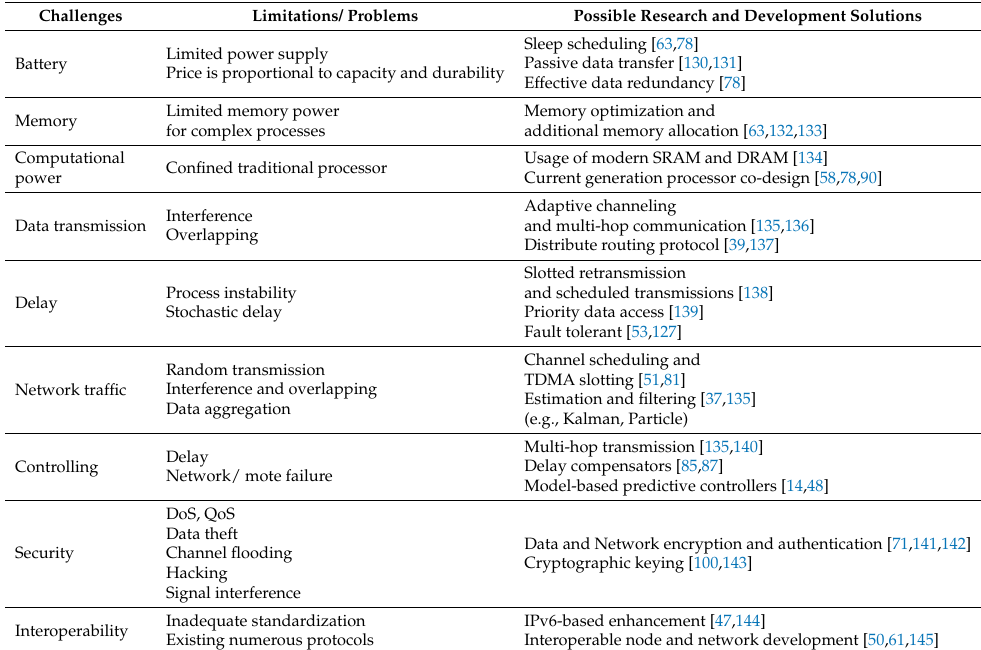
Table 8. WirelessHART challenges and possible research and development